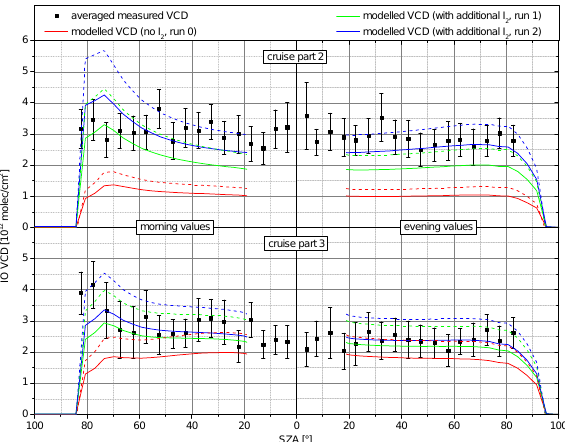
Fig. 8. Comparison of morning (left panel) and evening (right panel) values of measured and modelled IO VCDs as a function of SZA for the cruise part 2 (upper panel) and for the cruise part 3 (lower panel). The modelled VCDs are calculated from predictions of model runs 0, 1 and 2, according to Table 3 (solid red, green and blue lines) and the corresponding artificially degraded model VCDs are indicated by dashed lines. The measured VCDs are 5 ◦ SZA averages for the cruise part 2 and 3 (black squares), respectively.